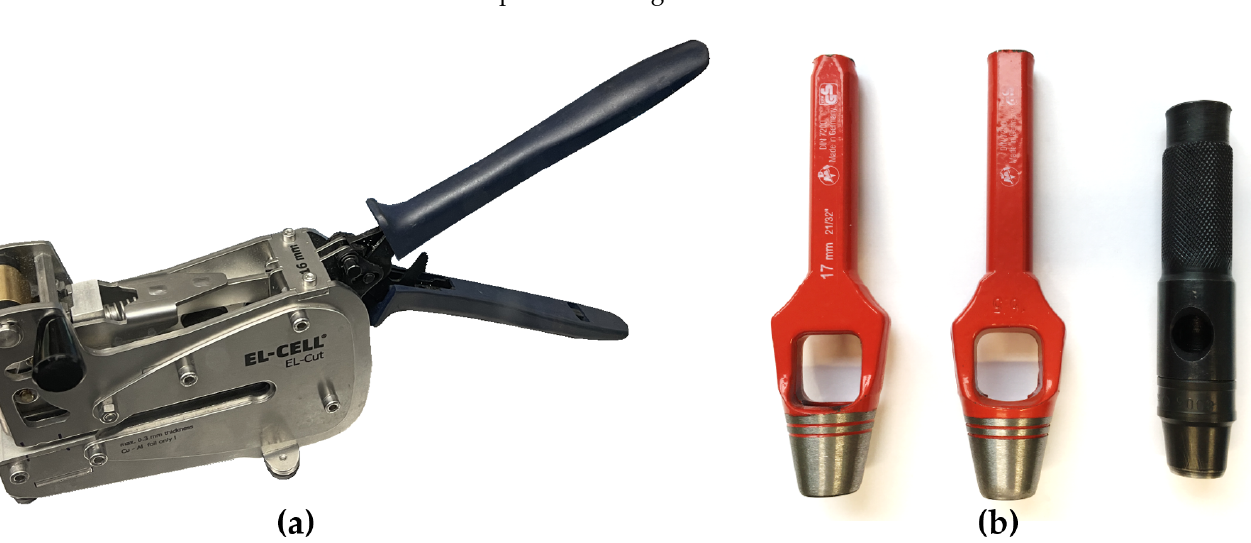
Figure 1. ( a ) EL-Cut from EL-CELL; ( b ) hollow punches in various diameters. The electrolyte was applied with a plunger-operated pipette from Eppendorf. Ce-